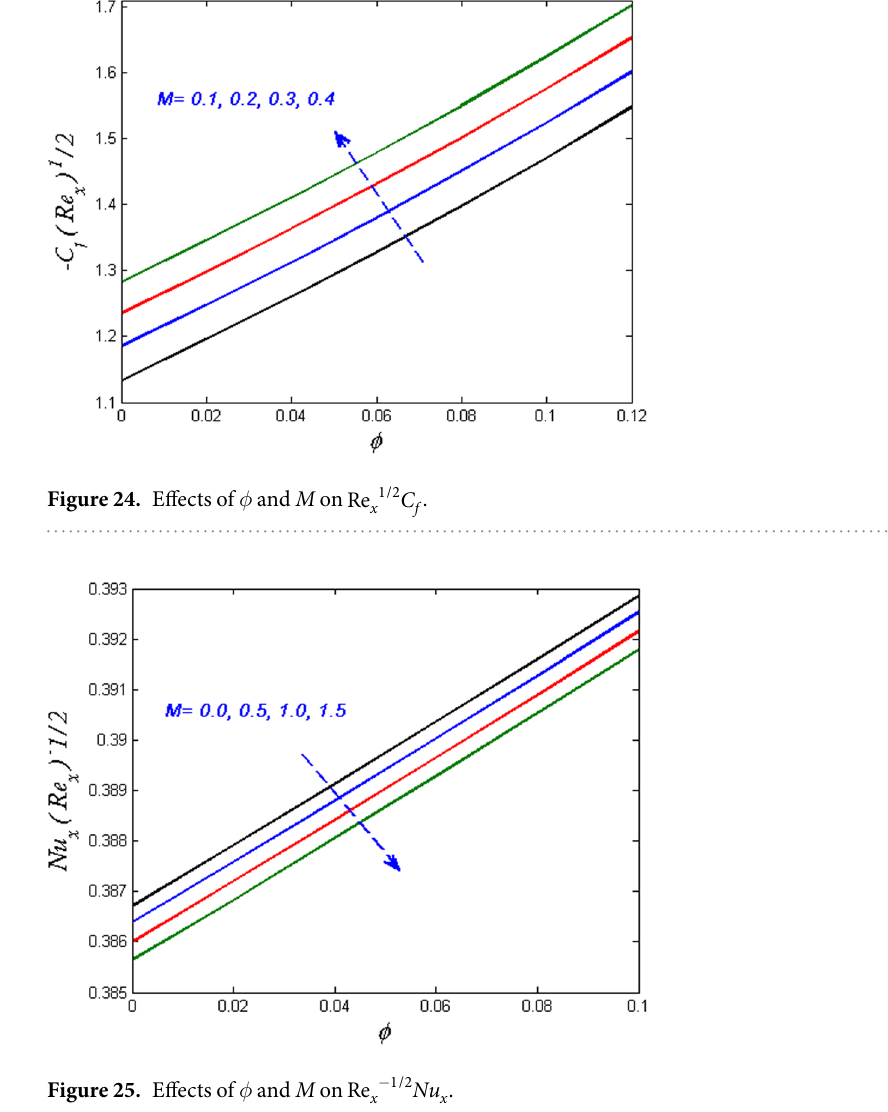
Figure 25. Effects of φ and M on